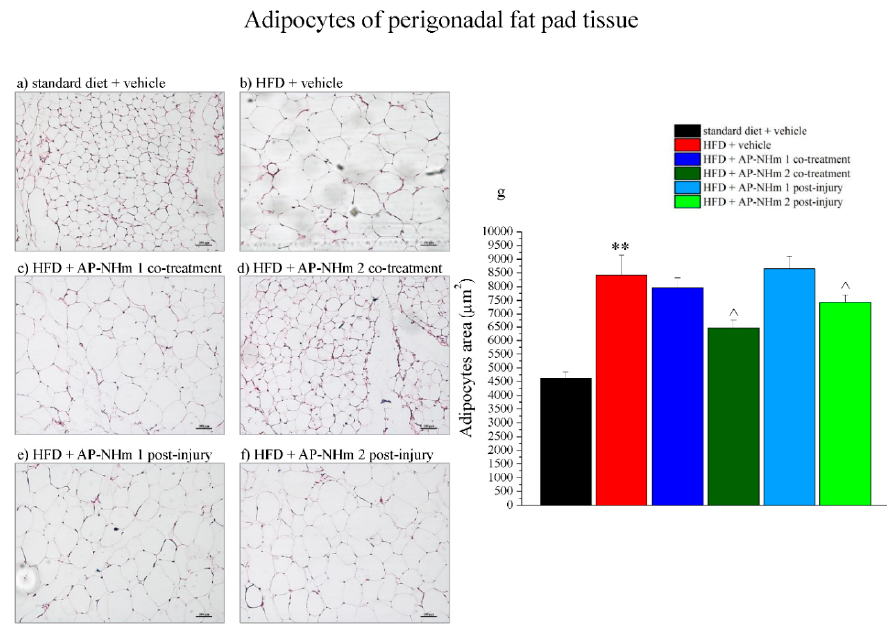
Figure 7. Effects of AP-NHm 1–2, in co-treatment or in post-injury treatment, on adipose tissue and adipocyte area of perigonadal fat pad. ( a – f ) Histology of tissue sections of adipose tissue: ( a ) standard diet + vehicle, ( b ) HFD + vehicle, ( c ) HFD + AP-NHm 1 co-treatment, ( d ) HFD + AP-NHm 2 co-treatment, ( e ) HFD + AP-NHm 1 post-injury, ( f ) HFD + AP-NHm 2 post-injury; ( g ) area of adipocytes ( µ m 2 ) in each group of treatment. Each value represents the mean ± SEM of 12 mice per group. ** p < 0.01 vs. standard diet + vehicle, ^^ p < 0.01 vs . HFD + vehicle.